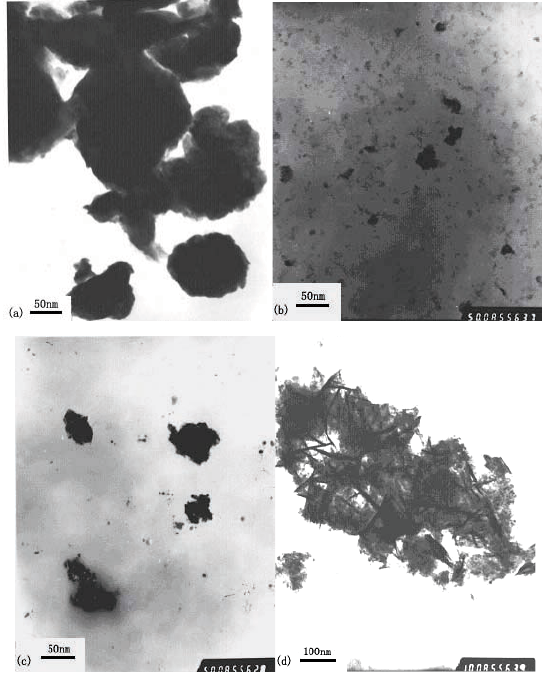
Figure 3. TEM morphologies of β -Ni(OH) conditions: (a) NaOH solution only; (b) NaOH